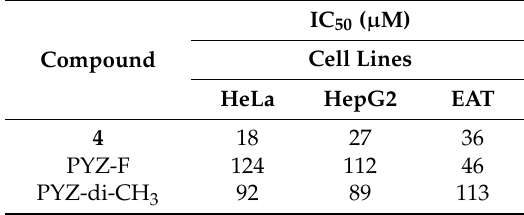
Table 2. Antiproliferative activity of compound 4 and its analogues.